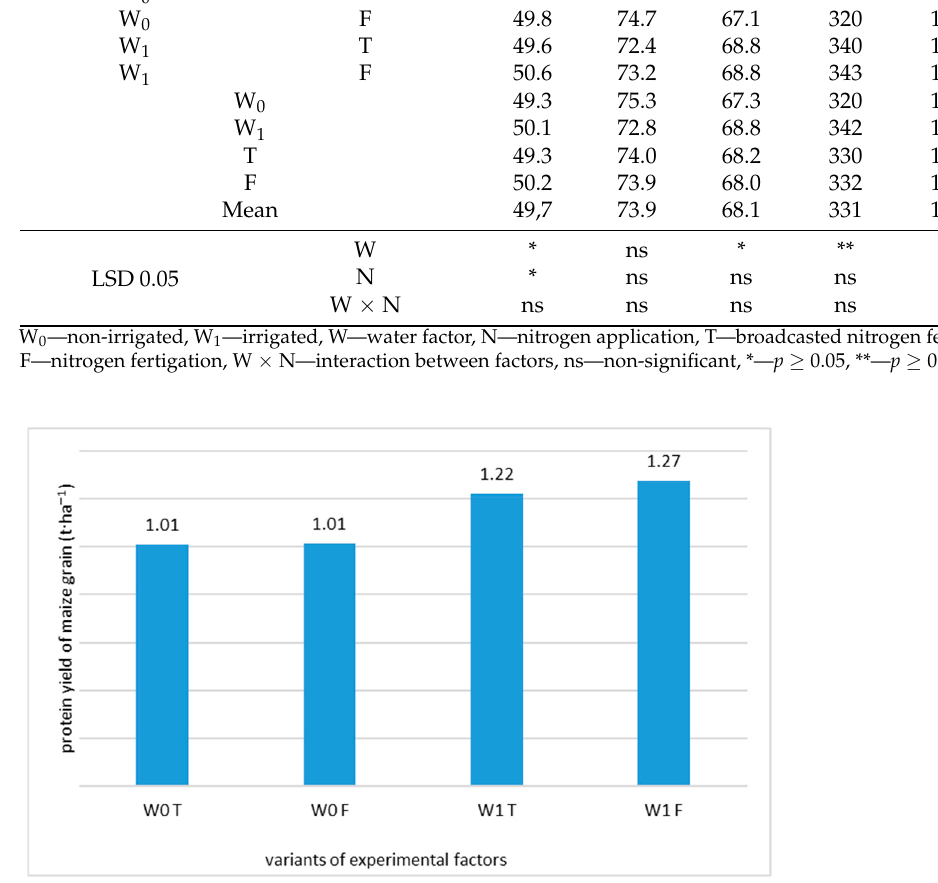
Figure 6. The effect of drip irrigation and nitrogen fertigation on the protein yield of maize cv. ‘Smolan’ (the average of 2015–2017).